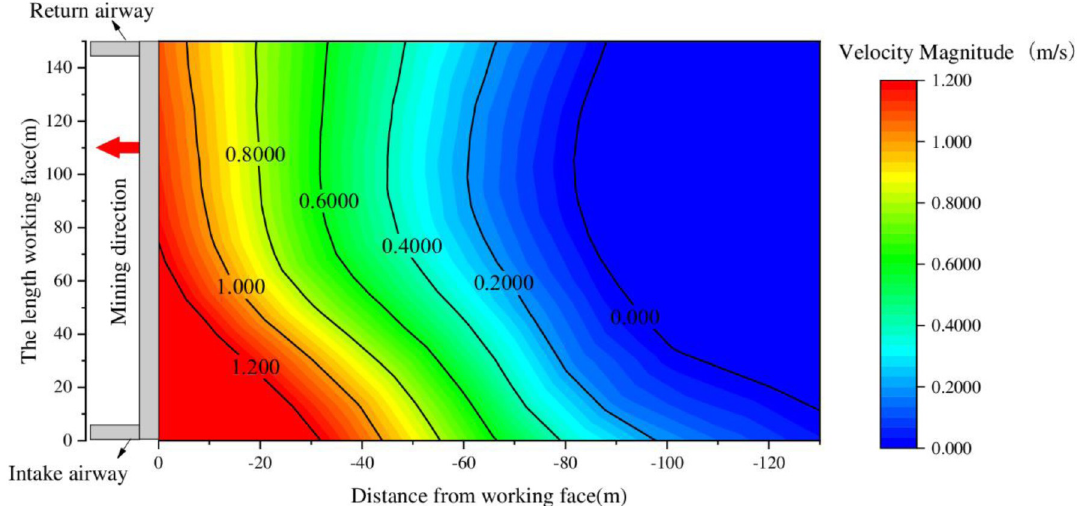
Fig 3. Distribution of the surface air leakage speed